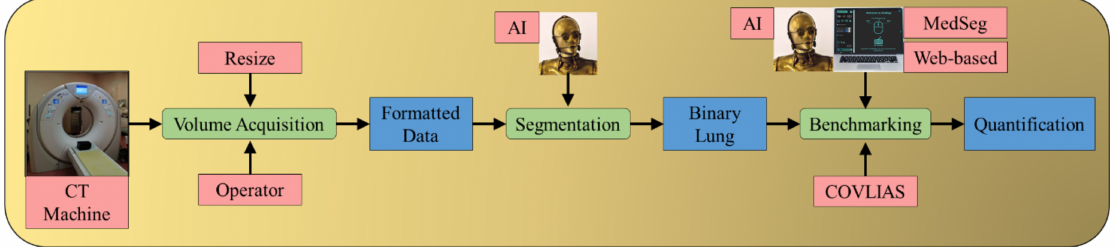
Figure 1. Pipeline for comparing AI-based COVLIAS and MedSeg. The benchmarking stage shows the comparison between COVLIAS and MedSeg. The CT machine uses the ITALIAN cohort during experimentation, and during validation, the CT machine uses the CROATIA